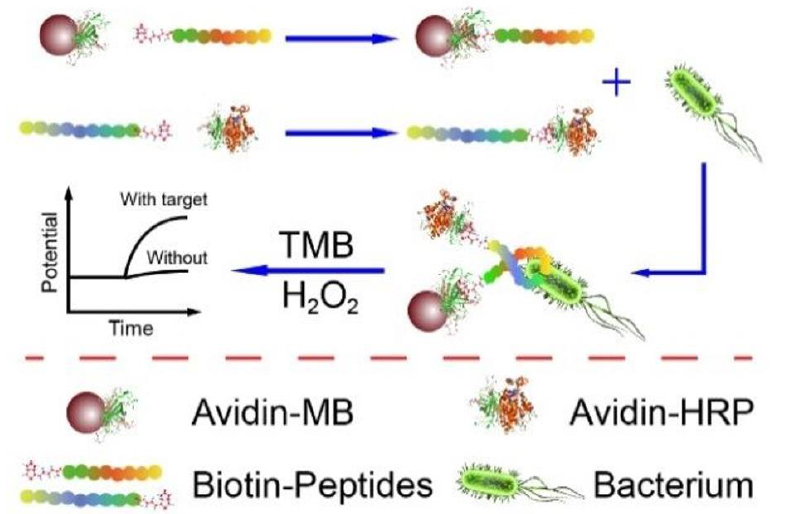
Figure 2. A potentiometric electrochemical biosensor composed of the biotinylated anti-bacterial peptide as a recognition element, magnetic beads as a concentrator of the bacterial cell, and enzymatic detection indicator. Copyright (2022) ACS publications [38].